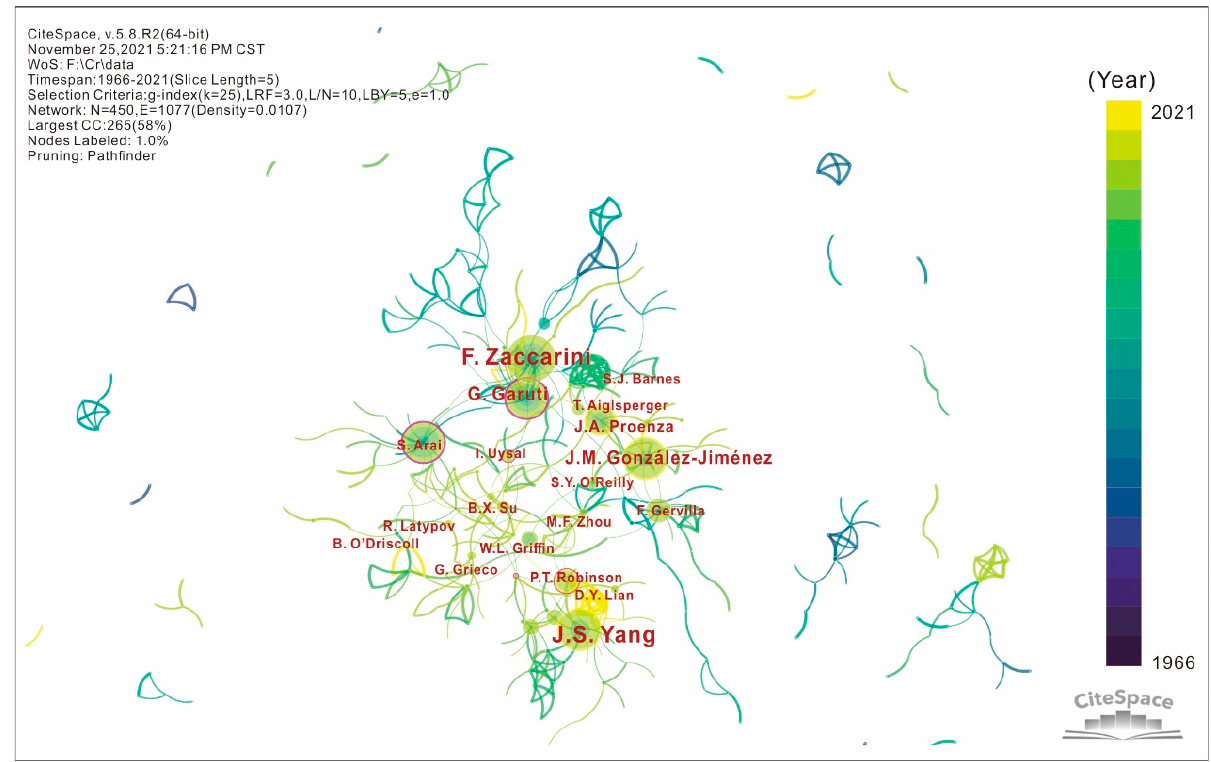
Figure 2. Co-occurring authors map. Table 1. Top 20 authors ranked by the number of publications with a focus on chromitite. Rank